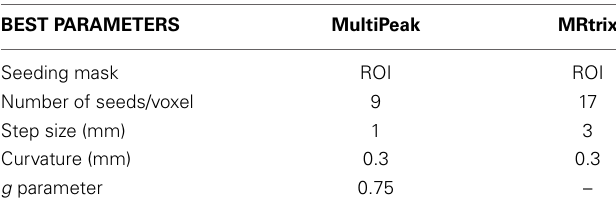
Table 2 | Best parameters used for MultiPeak and MRtrix according to VB, IB, and VC scores.